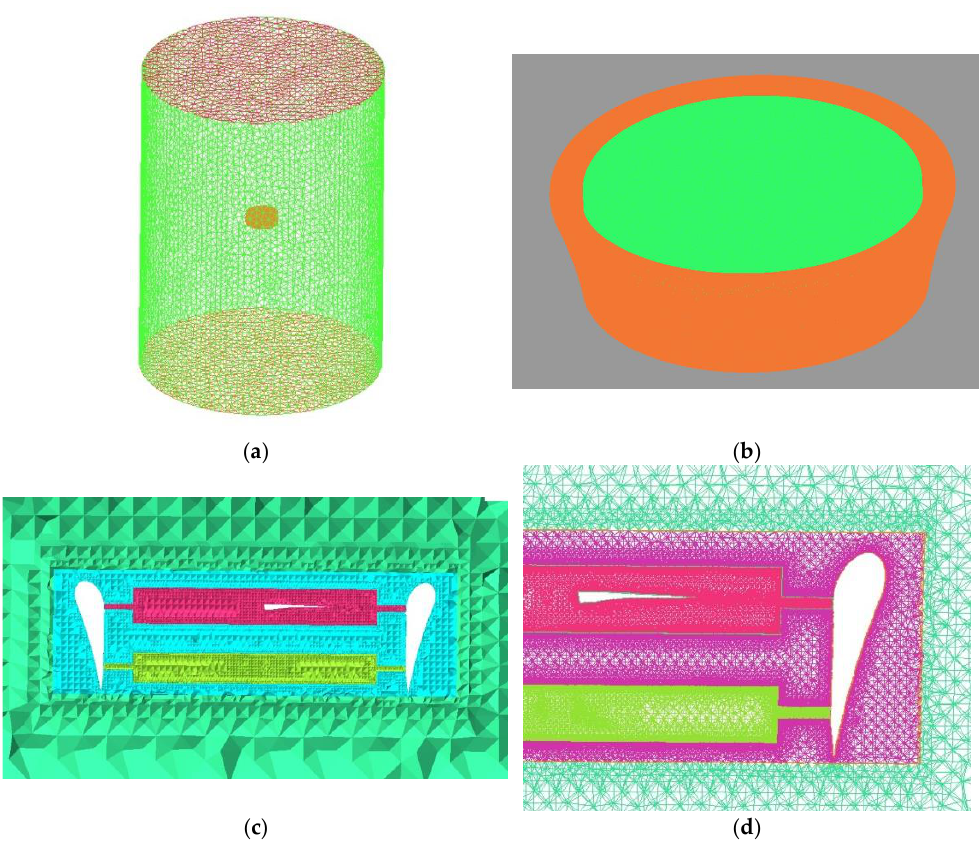
Figure 6. Grid diagram: ( a ) far-field grid; ( b ) grid of duct surface; ( c ) body grid sections; ( d ) grid detail of propeller and duct.